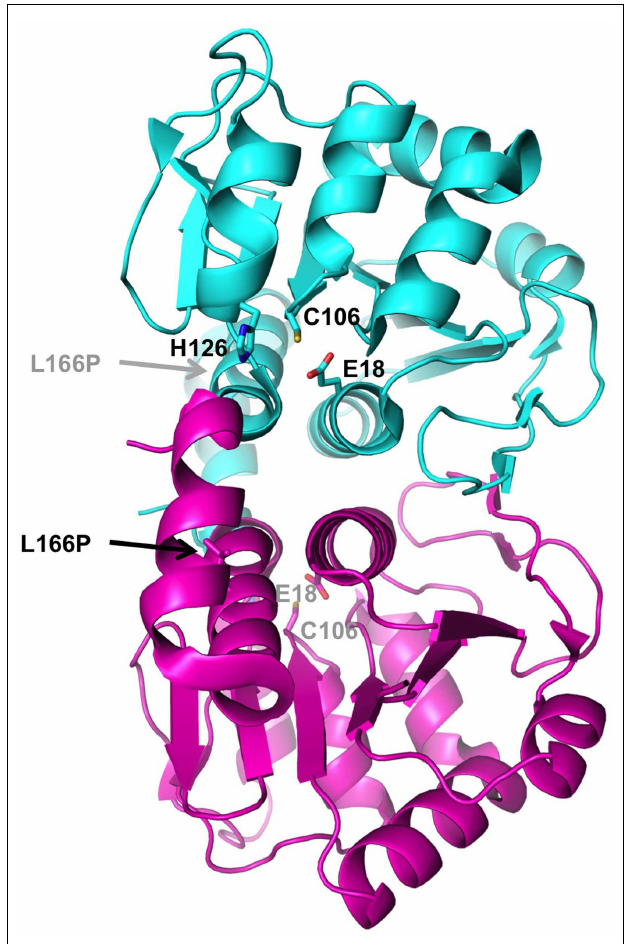
FIGURE 3 | Structure of DJ-1 .The crystal structure of human DJ-1 (PDB 1P5F) was used to generate this dimer, which represents the biologically active unit.The two subunits are colored in cyan and magenta. Residues of the active site catalytic triad (Glu18, Cys106, His126) are shown as sticks. The location of the PD mutation that disrupts dimerization (L166P) is indicated by